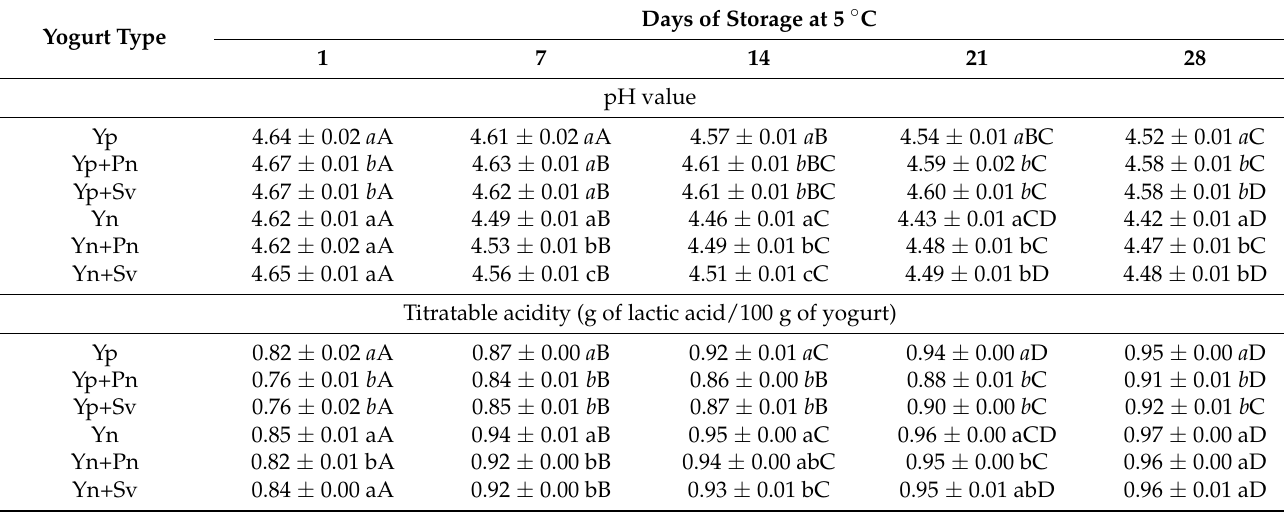
Table 2. Changes in the pH value and titratable acidity of probiotic (Yp) and natural (Yn) yogurt with or without scCO 2 /H 2 O extracts from P. nigra (Pn) and S. viminalis (Sv) during storage *. Yogurt